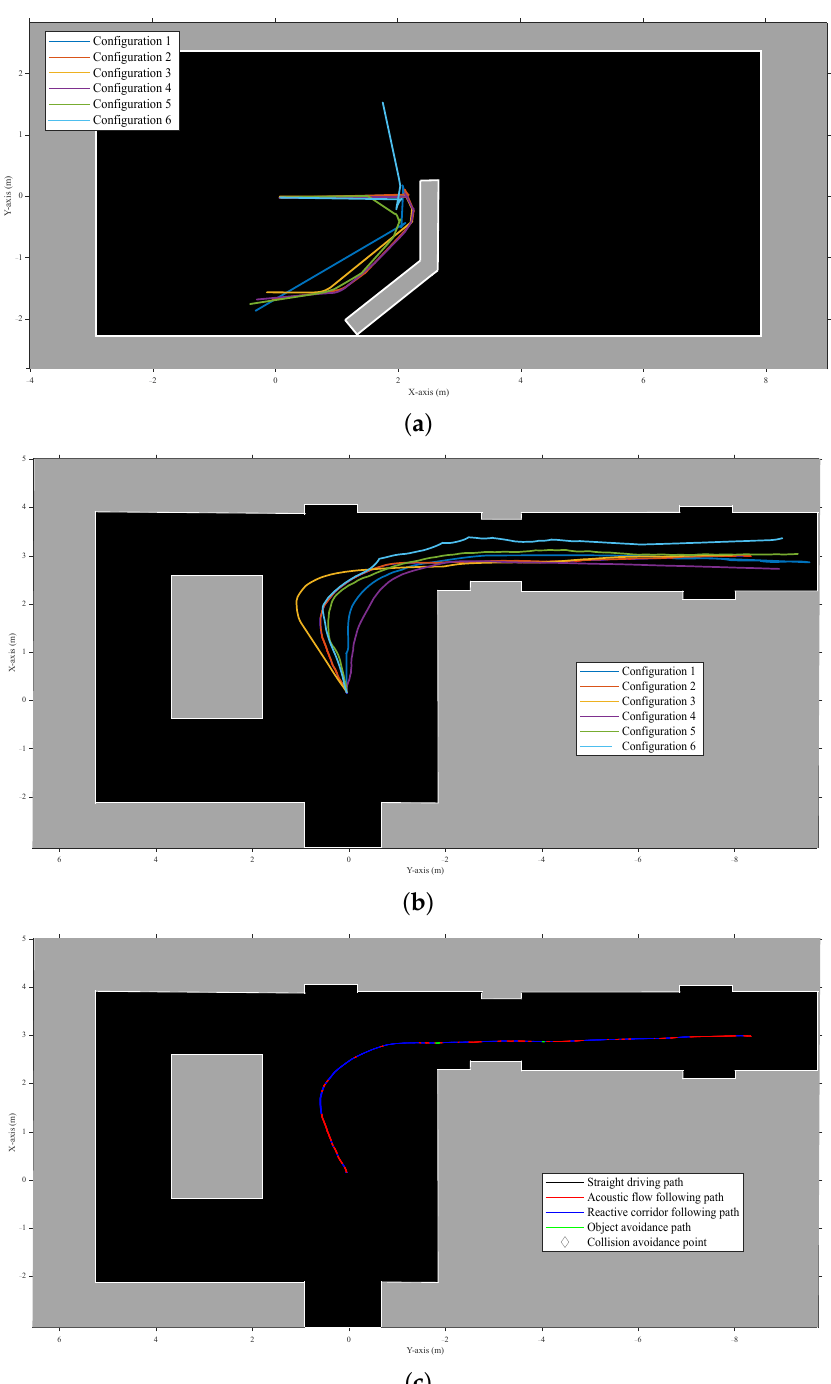
Figure 12. The maps shown are manually cleaned-up versions of the occupancy grid results of a LiDAR SLAM algorithm that was run offline. Although the behavior layer focused on in each scenario is specific, all layers were active during the experiments. ( a ) Results for a real mobile platform navigating a room with an artificially added wall that needs to be dealt with safely. The figure shows the trajectories of the six different configurations that were used for validating the adaptability of the layered controller. The trajectories were combined by using a single starting point. ( b ) Experimental results for a real mobile platform navigating a T-shaped corridor. The figure shows the trajectories of the six different configurations that were used for validating the adaptability of the layered controller. The trajectories were combined by using a single starting point. ( c ) This figure shows one of the individual trajectories of ( b ), indicating for each point on the trajectory what layer of the controller was generating the output